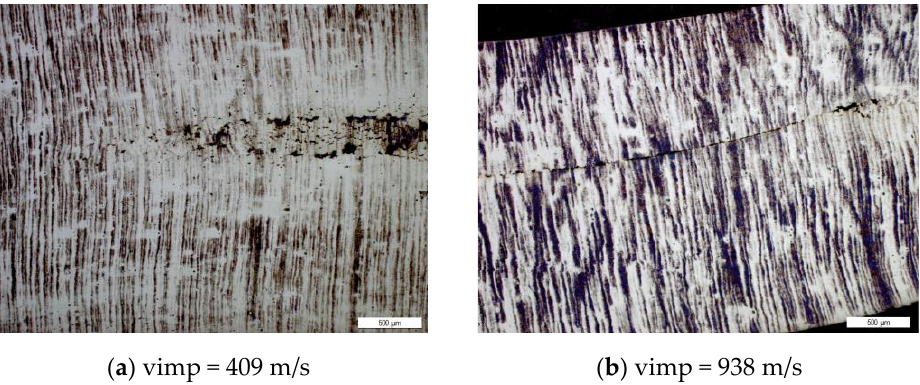
Figure 9. Metallographic microscope observation of internal structures of recovered specimens subjected to impact velocities of 409 m/s and 938 m/s.